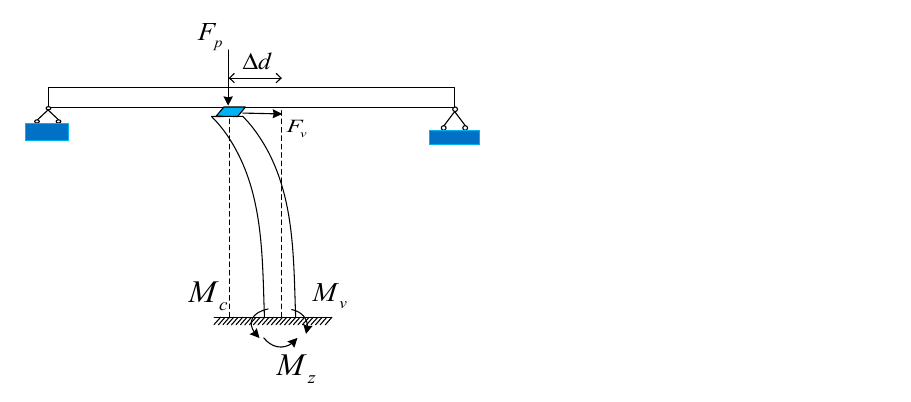
Figure 7. Force diagram at the bottom of the pier under eccentric compression.